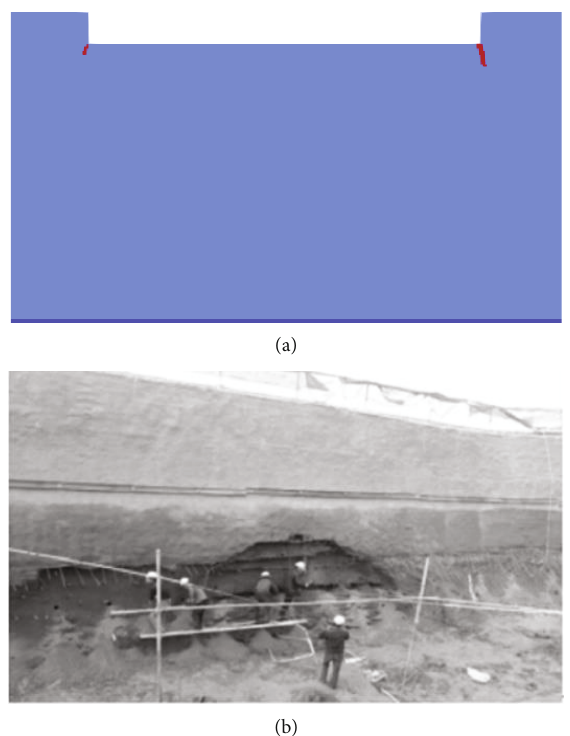
Figure 11: Comparisons of foundation pit failure positions between IKSPH and engineering practice. (a) IKSPH results. (b) Engineering practice positions.